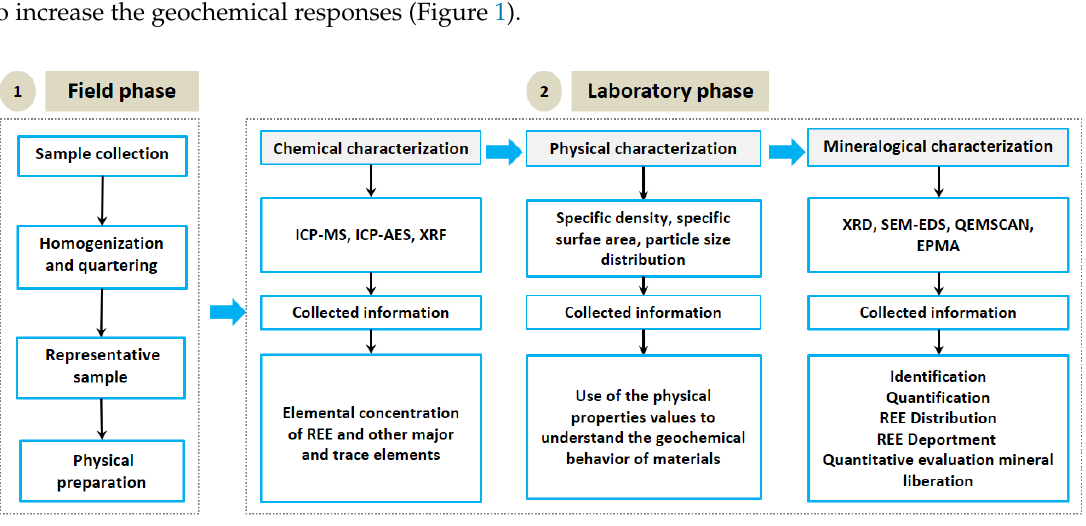
Figure 1. REE-bearing minerals characterization methodology.